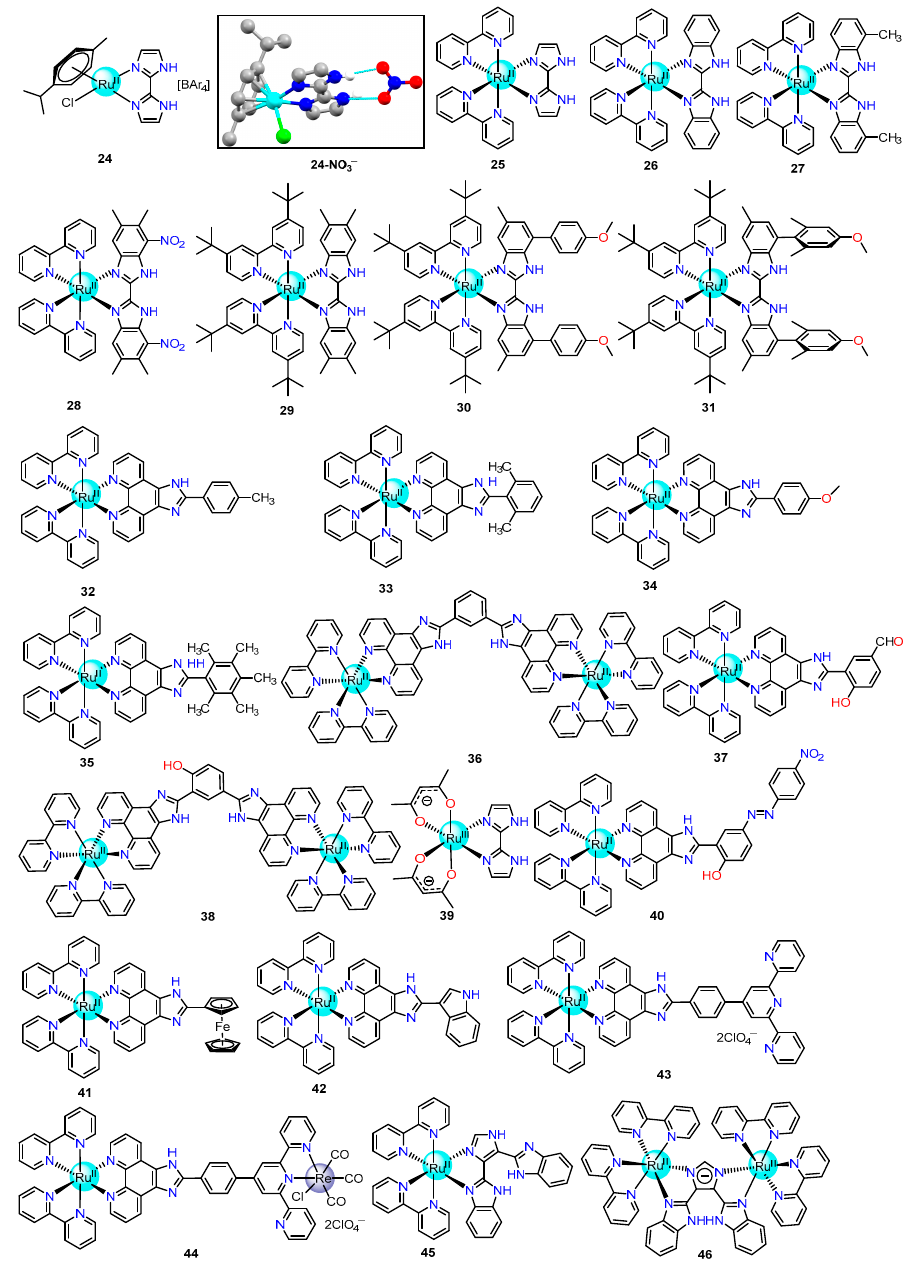
Figure 5. Structures of biimidazole / imidazole-based Ru(II) complexes 24 – 46 and the crystal struc- ture of 24 -NO 3 − complex. [Adapted from ccdc no.279202] .